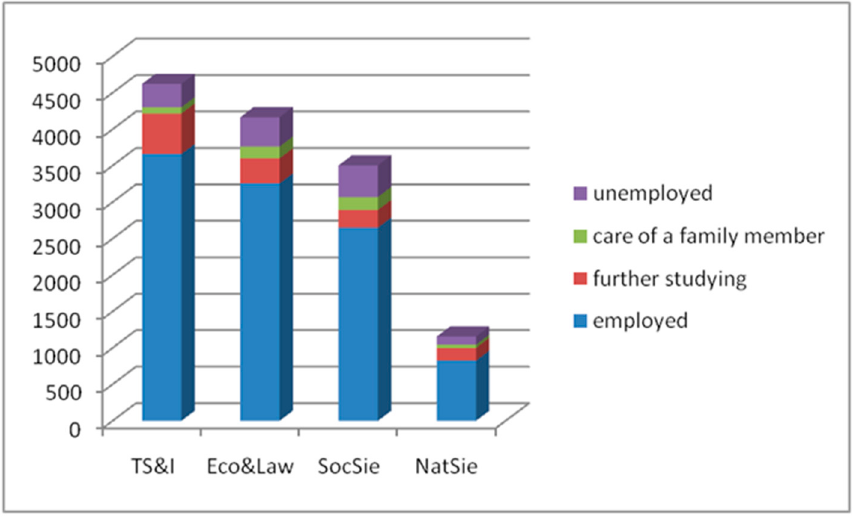
Figure 1. Structure of respondents.